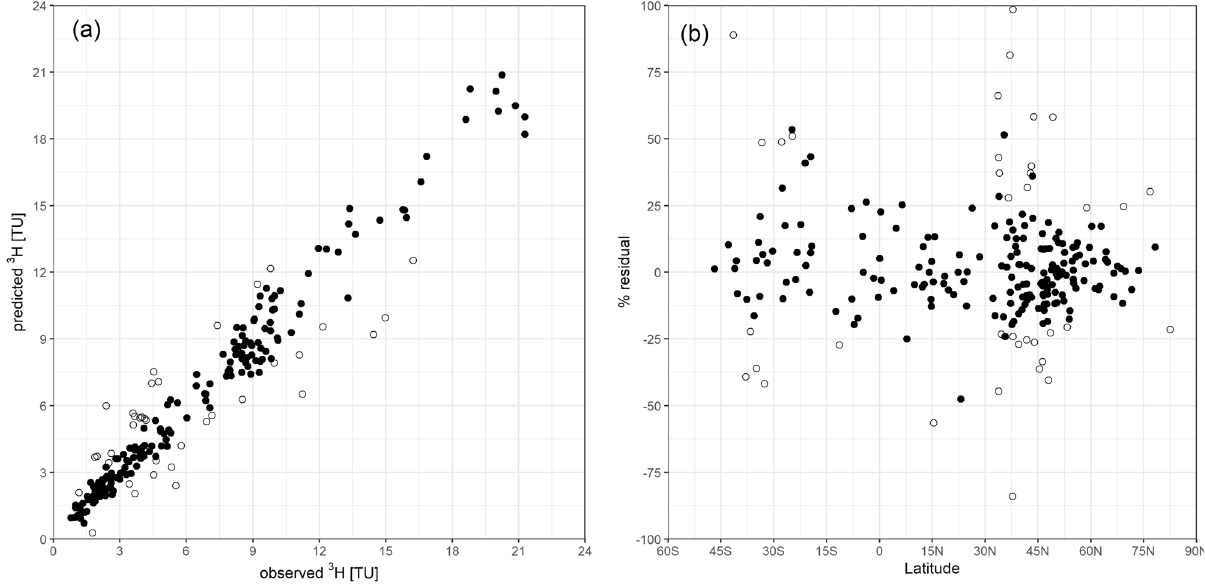
Figure 2. 3 H predictive model validation. Left: predicted vs observed contemporary 3 H contents in global precipitation expressed in tritium units (TU). Right: model 3 H residuals expressed as percent deviation between predicted and observed mean tritium values vs latitude. Open circles indicate data points with biases > 20% or beyond the MAB. Figure created in R 4.1.0 (with ggplot2 3.3.5 library, all https:// cran.r- proje ct.